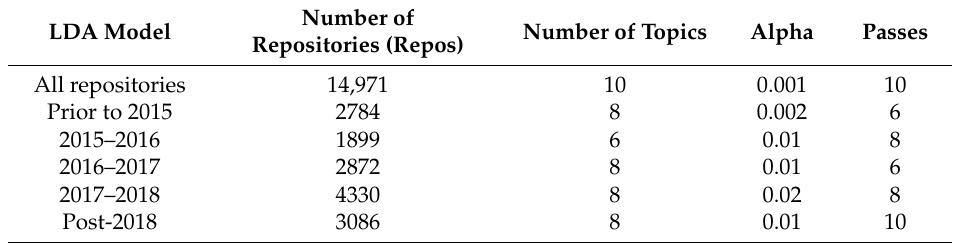
Table 3. Latent Dirichlet allocation (LDA) models: Five models that built on yearly repository